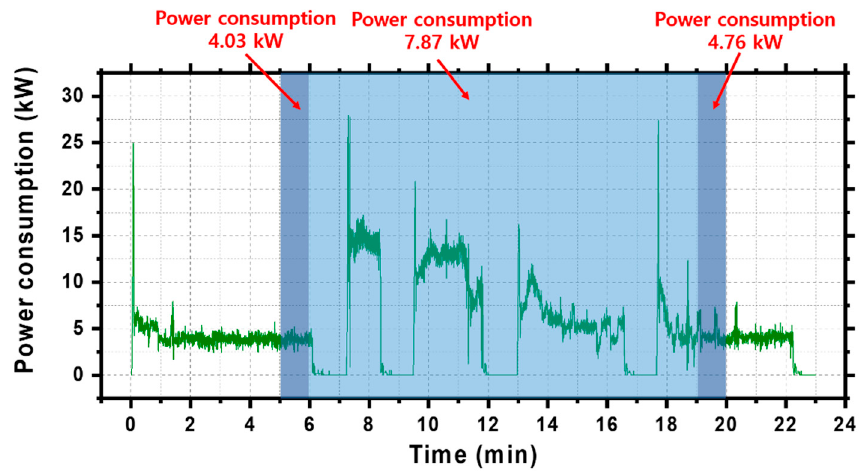
Figure 12. Comparison-based filtering method.